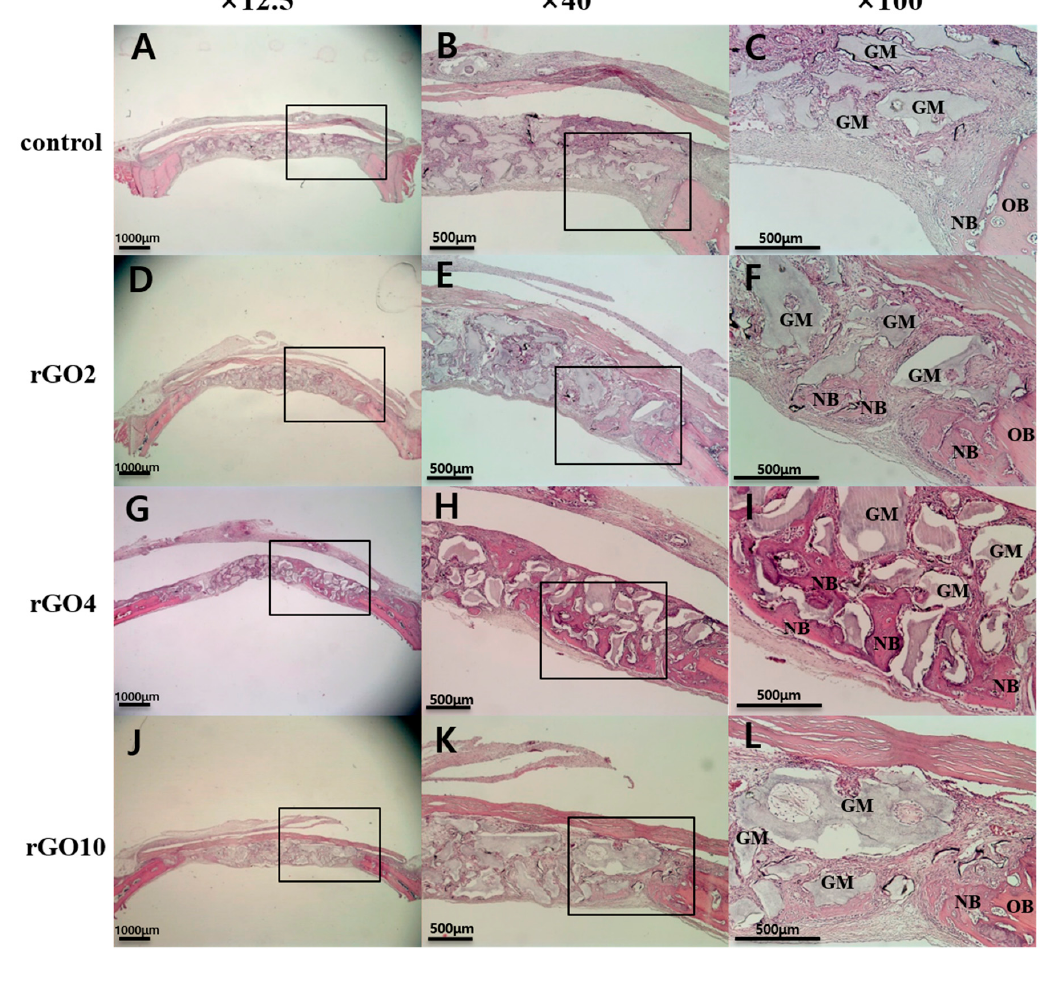
Figure 7. Histological view of hematoxylin and eosin (H&E) stained specimens obtained at 2 weeks after surgery. Black box is the area of interest. ( A – C ) Control group; ( D – F ) rGO2 group; ( G – I ) rGO4 group; ( J – L ) rGO10 group; OB: old bone, NB: new bone, GM: bone graft material (Original magnifications: 12.5× ( A , D , G , J ), 40× ( B , E , H , K ), 100× ( C , F , I , L )).